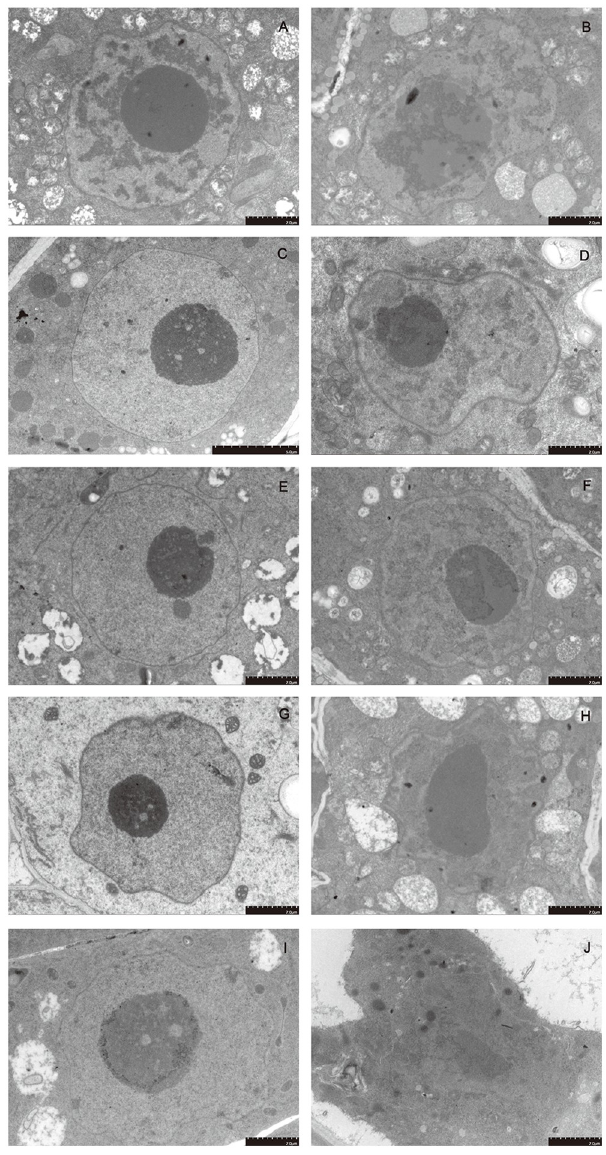
Fig 5. Ultrastructure of meristematic cell nuclei in different preimbibition and dehydration states. A, C, E, G and I show meristematic cell nuclei of the hypocotyl with 0, 3, 6, 18 and 24 h of preimbibition, respectively. B, D, F, H and J show meristematic cell nuclei of the hypocotyl with 0, 3, 6, 18 and 24 h of preimbibition after 24 h of dehydration,